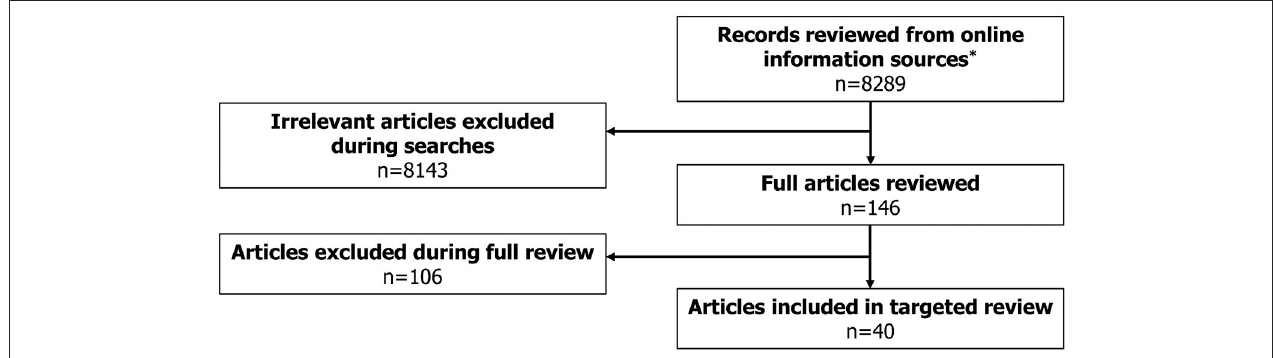
FIGURE 1 | Literature review flowchart. *Online information sources included: Guideline Central, National Organization for Rare Disorders (NORD), American Academy of Neurology (AAN), American Epilepsy Society (AES), International League Against Epilepsy (ILAE), Orphanet, Google, National Institute for Health and Care Excellence (NICE), Pharmaceutical Benefits Scheme (PBS), Canadian Agency for Drugs and Technologies in Health (CADTH), Ministerio de Sanidad, Consumo y Bienestar Social (MSCBS), Agenzia Italiana del Farmaco (AIFA), Haute Autorité de Santé (HAS), Gemeinsamer Bundesausschuss (G-BA), Bundesamt für Gesundheit (BAG), State of Israel – Ministry of Health, Ministry of Health, Labour and Welfare (MHLW).